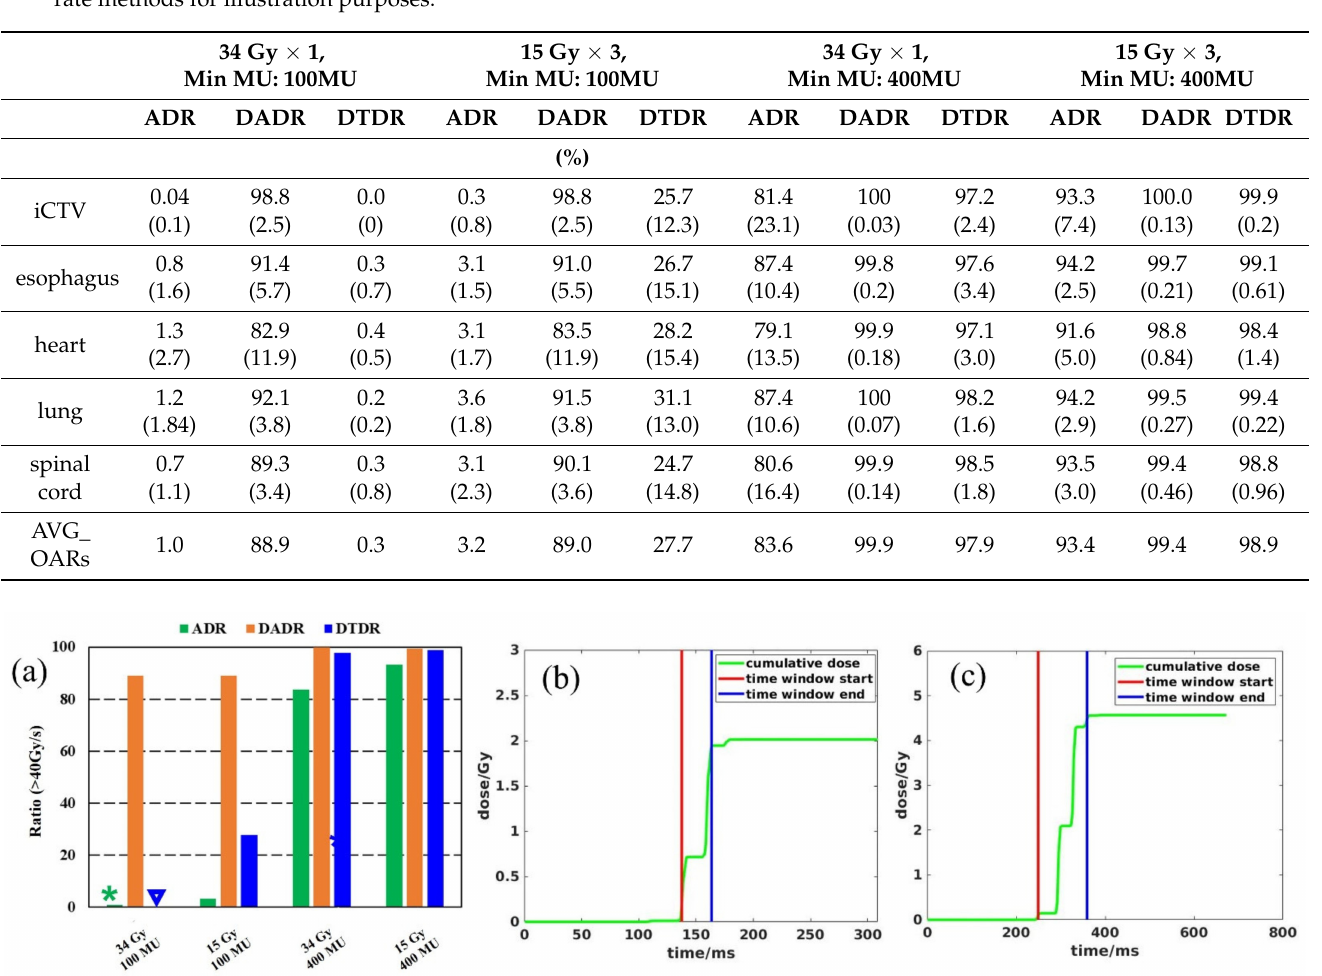
Figure 7. ( a ) is the averaged V 40Gy/s for all the OARs under each of the three dose rate methods; the ADR and DTDR are 1.0% and 0.3% are represented by a star and triangle for better illustration. ( b , c ) Time structures determined by dose-threshold 0.1 Gy for ADR calculation under 15 Gy/fraction and 34 Gy/fraction,